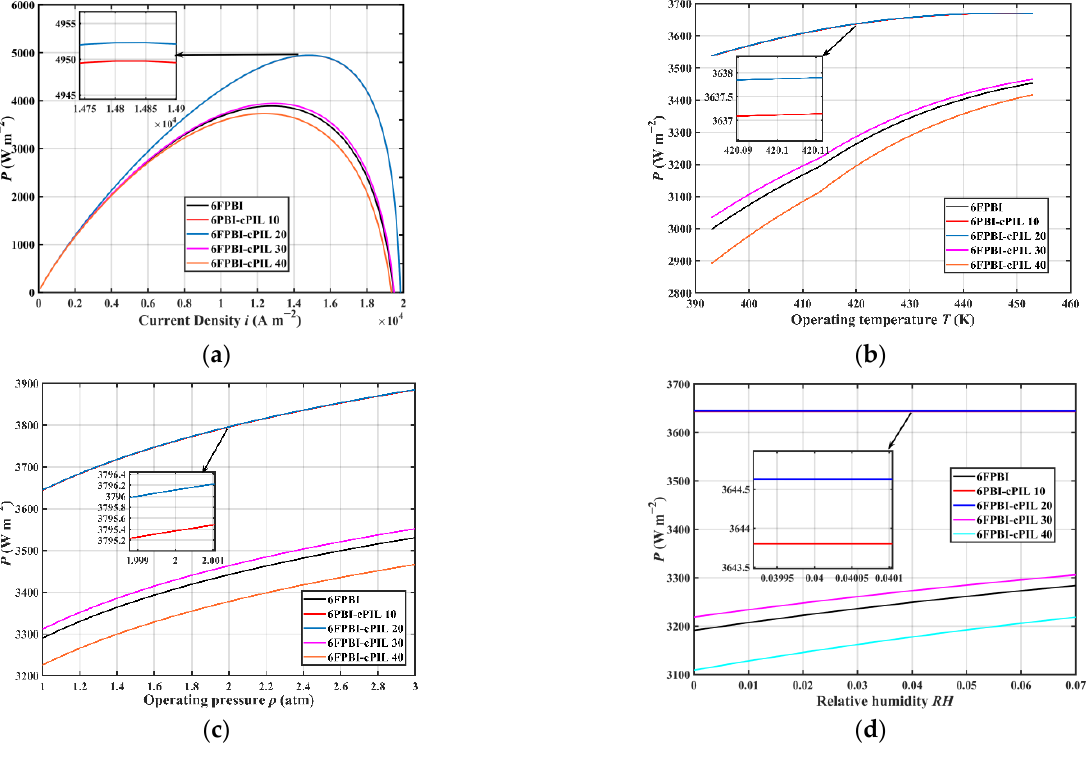
Figure 2. The power density of the HT-PEMFC single cell using 6FPBI membranes under different ( a ) current density, ( b ) operating temperature, ( c ) operating pressure, and ( d ) relative humidity.